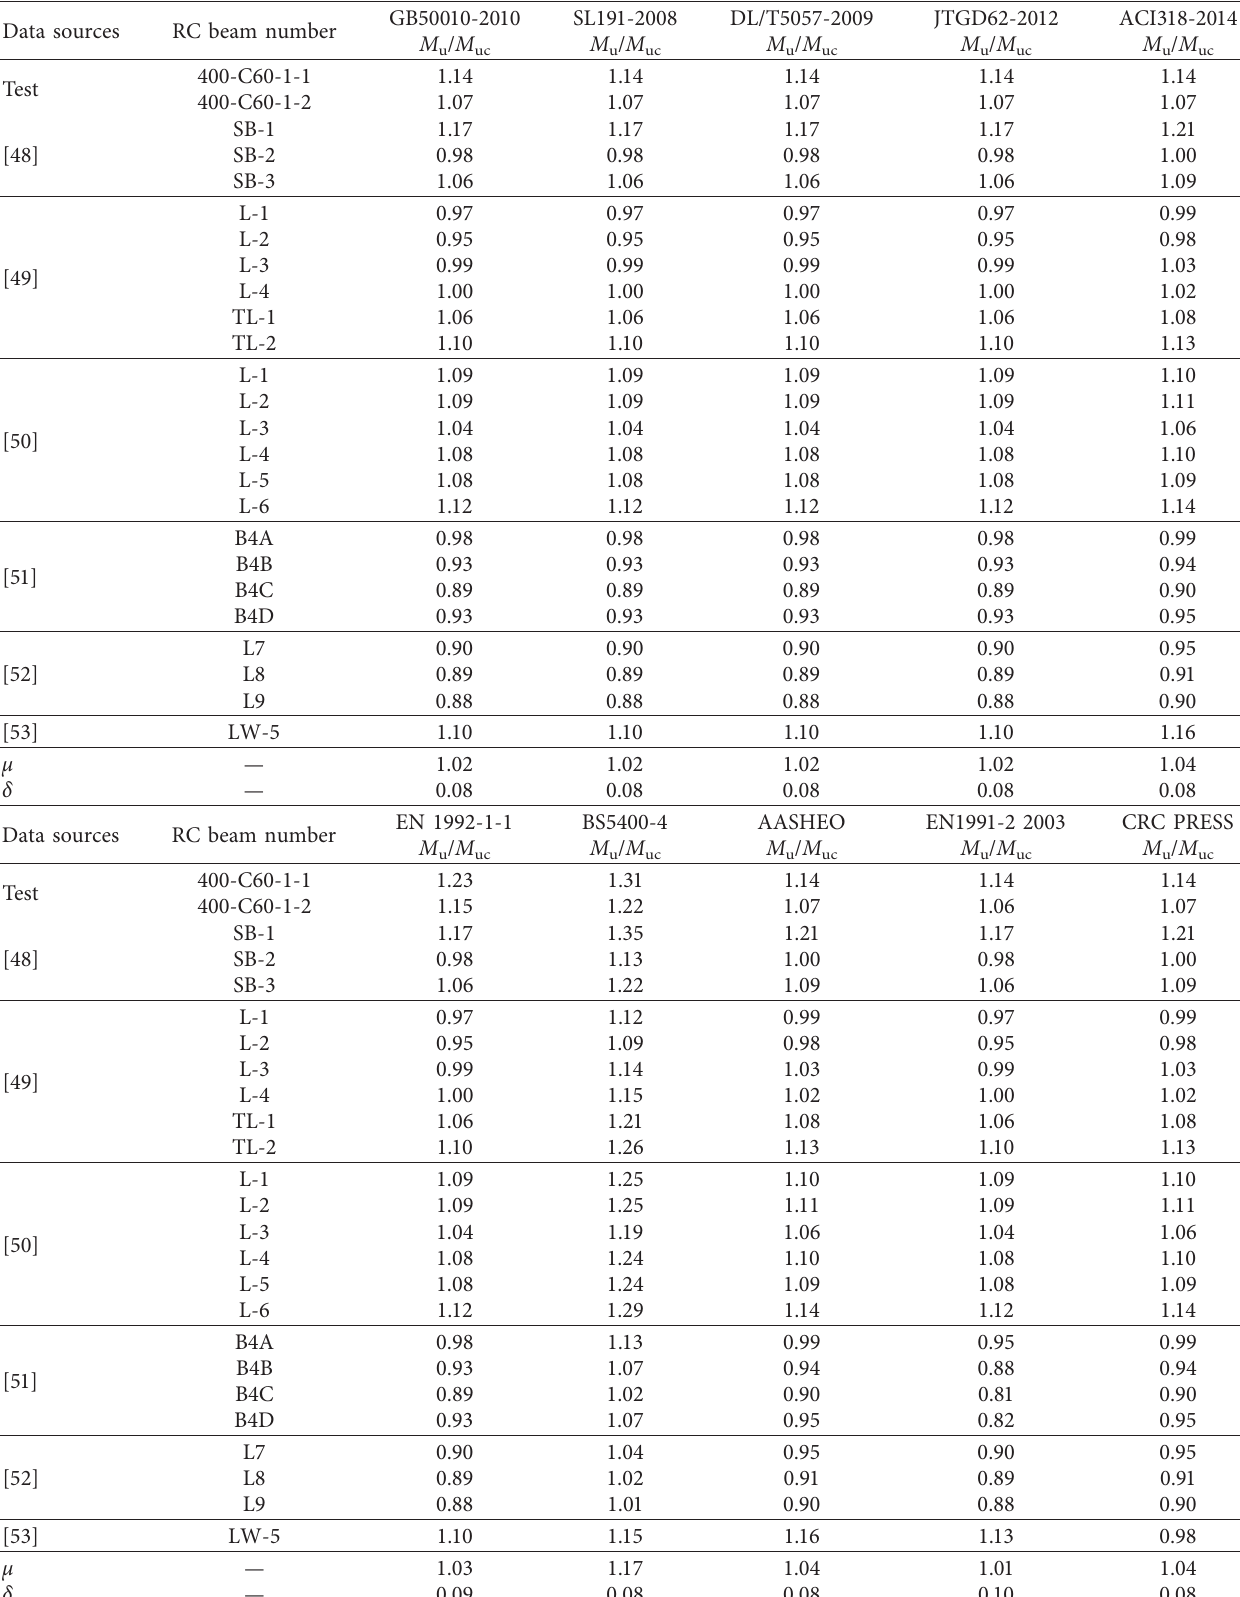
u with M uc calculated by different codes for beams with 400MPa steel bars.